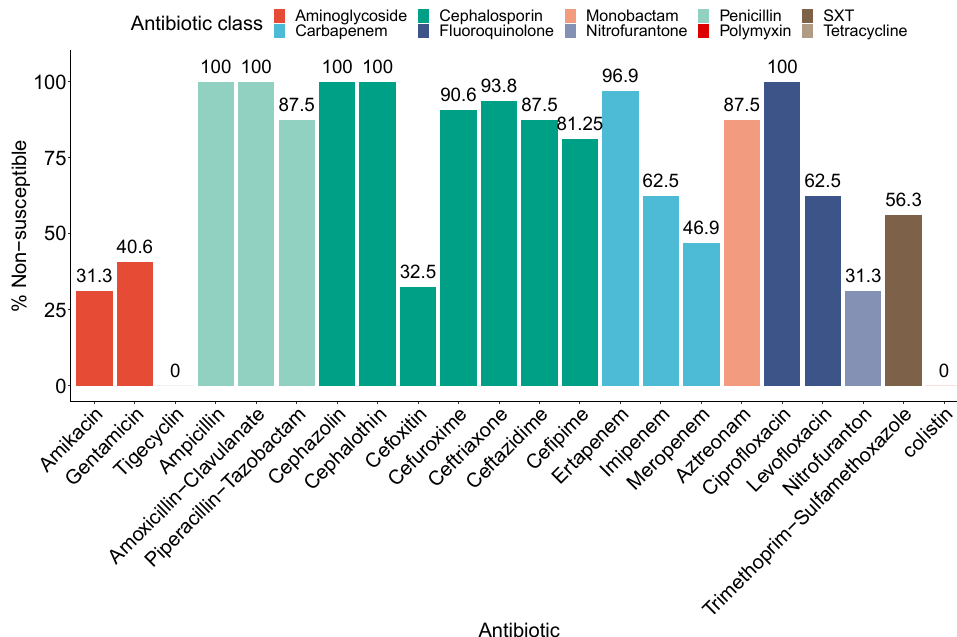
Figure 1. Phenotypic profile of the carbapenem-resistant Enterobacteriaceae isolated from children (0–15 years old) with urinary tract infections. The isolates were tested for antibiotic resistance against 22 clinically relevant antibiotics using the Phoenix NMIC/ID-5 panel (BD Biosciences, Heidelberg, Germany). The figure depicts the percentage of isolates that are non-susceptible to each antibiotic. The bars are colored according to the antibiotic class.